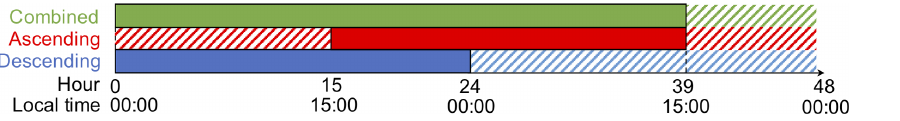
Figure 1. Representation of the timescale of the combined (ASC and DES averaged together) KIMURA daily sea ice motion product, as well as the timescales of ASC and DES